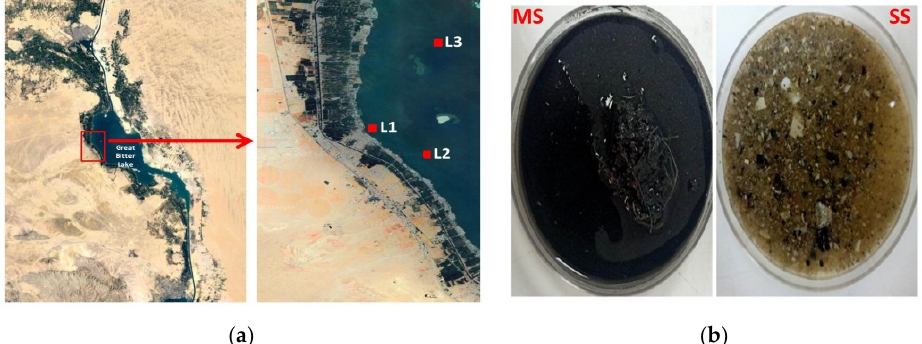
Figure 1. ( a ) The map indicates the sampling locations from the Great Bitter Lake—L1: 30°20 ′ 08 ″ N 32°18 ′ 25 ″ E, L2: 30°19 ′ 31 ″ N 32°19 ′ 38 ″ E and L3: 30°21 ′ 52 ″ N 32°19 ′ 48 ″ E. ( b ) Difference in the physical appearance between the collected sediment types. MS: muddy sediment. SS: sandy